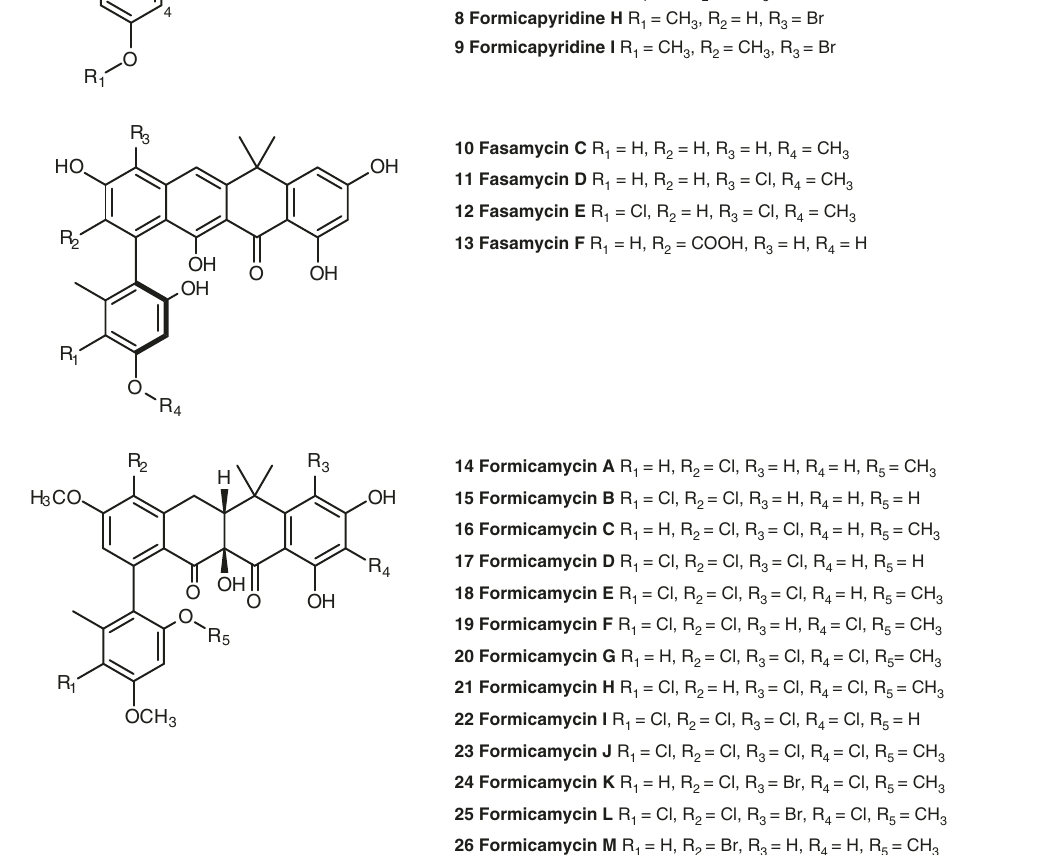
Fig. 1 Chemical structures of metabolites isolated from Streptomyces formicae . Compounds 1 – 9 and 13 were discovered during this study whereas 10 – 12